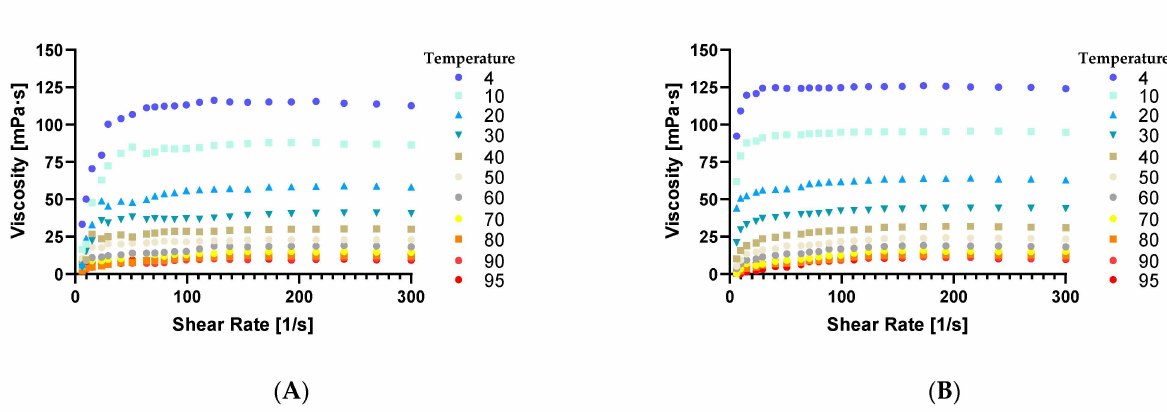
Figure 2. The viscosity of extracted tomato seed oil derived from ( A ) cold break method ( B ) hot break ( B ) method between 4–95 ◦ C (Graph Prism Version